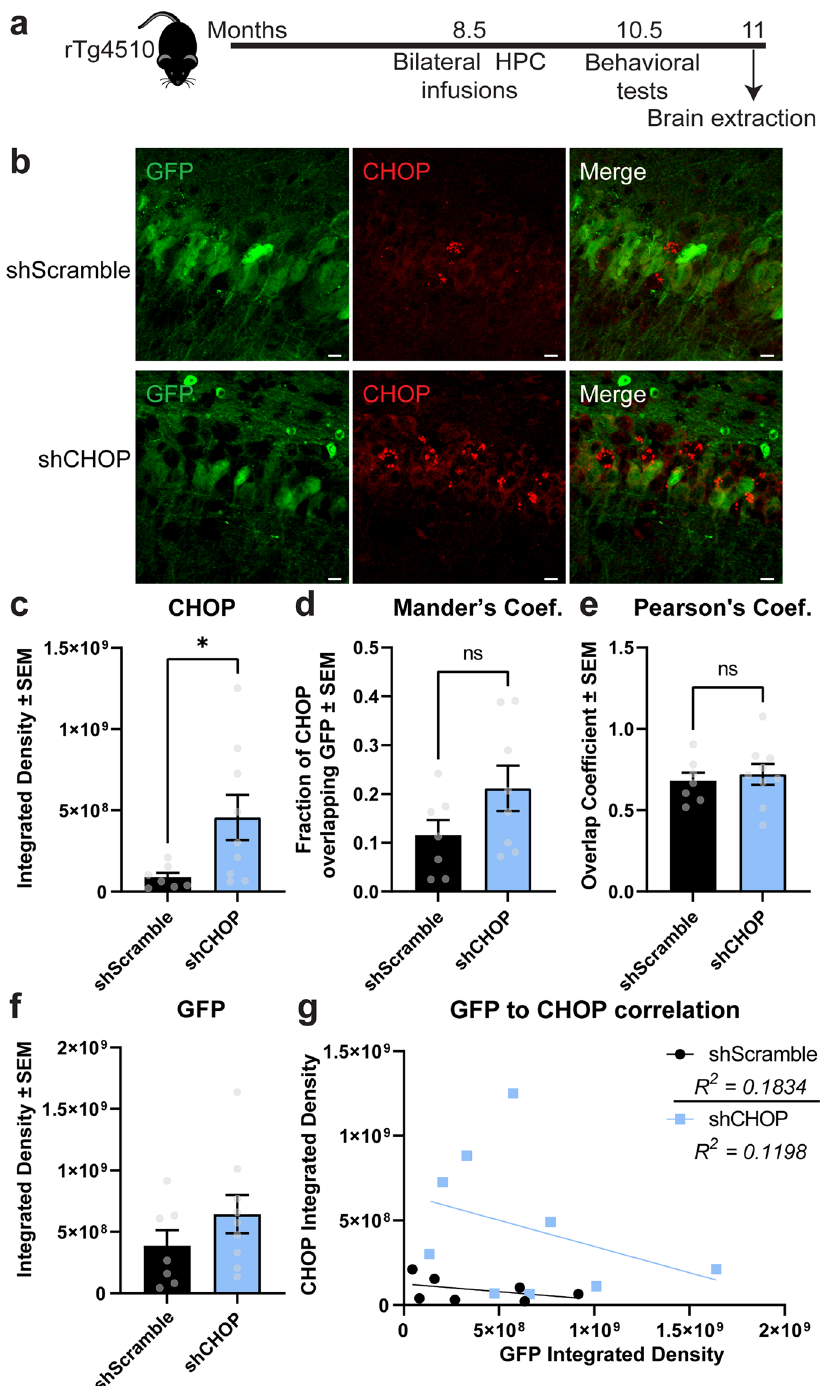
Figure 2. Experimental timeline and viral confirmation of shScramble and shCHOP injections. ( a ) rTg4510 mice received hippocampal injections of AAV9 shScramble or shCHOP containing EGFP tag at 8.5 months of age. ( b ) Representative images of EGFP and CHOP signal in hippocampal regions from mice expressing AAV9- shScramble [n = 7] or AAV9-shCHOP [n = 9]. ( c ) Sections expressing EGFP were analyzed for the integrated density of GADD153 (CHOP protein) staining in the hippocampus of rTg4510 mice injected as described above. Colocalization analysis was performed by ( d ) Mander’s coefficient (Coef.) to estimate the fraction of CHOP being colocalized with GFP and ( e ) Pearson’s Coef. to measure the co-occurrence of GFP/CHOP intensities. ( f ) Sections were also analyzed for the integrated density of GFP fluorescence in the hippocampus. ( g ) A correlation between viral transduction (GFP) and CHOP was performed. Data are represented in standard error of the mean (± SEM) and analyzed by unpaired Student’s t-test. Statistical significance is shown by *p = 0.0384. Scale bar represents 20 µm. CHOP CCAAT-enhancer binding protein homologous protein, GFP green fluorescent protein, HPC